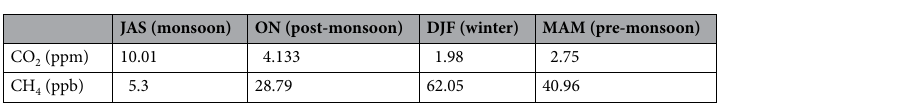
Table 2. Amplitude (maximum − minimum) of diurnal variation for the different